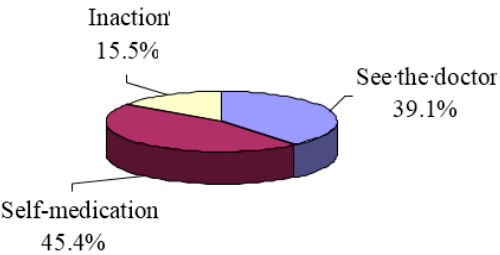
Figure 2. Respondent’s medical treatment choice.